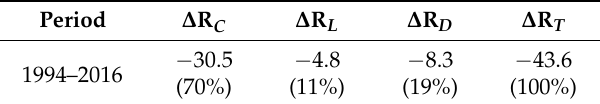
Table 3. Results of two-stage method (unit: km 3 ). Period